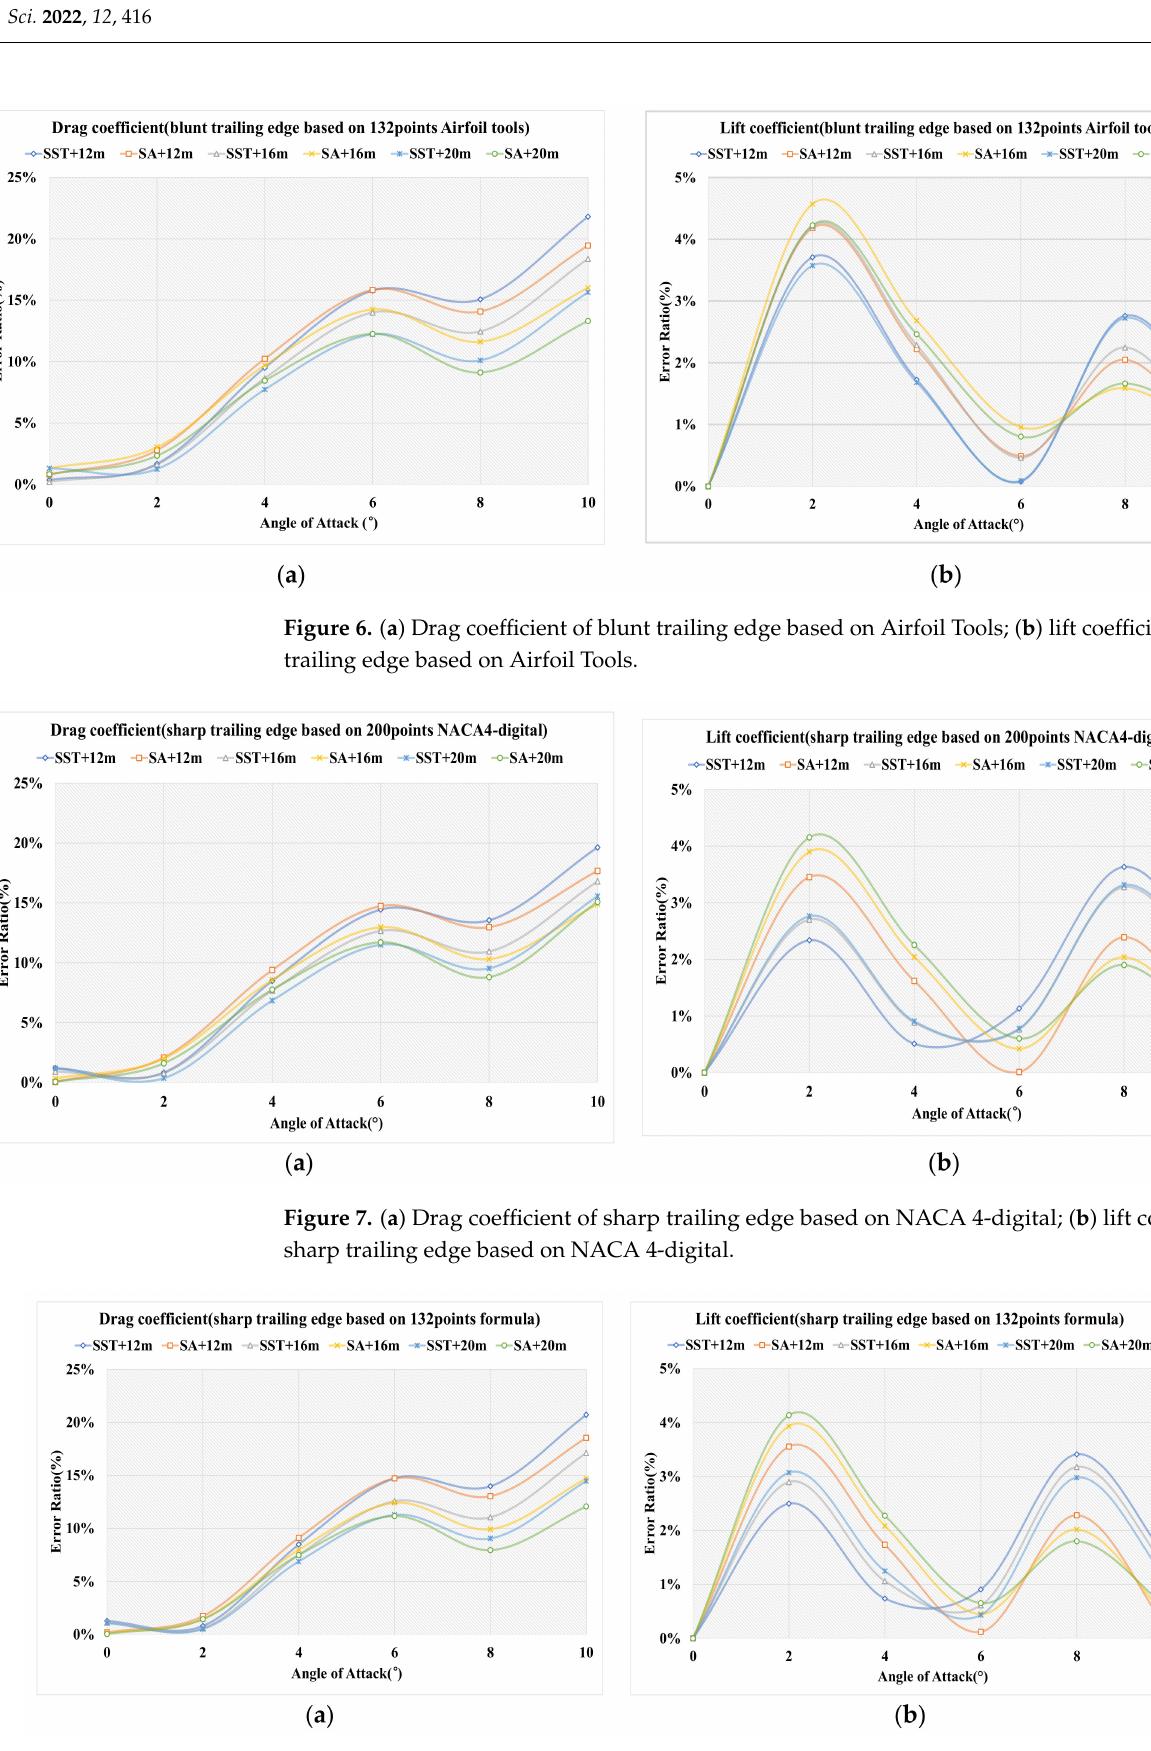
Figure 8. ( a ) Drag coefficient of sharp trailing edge based on 132 points formula; ( b ) lift coefficient of sharp trailing edge based on 132 points